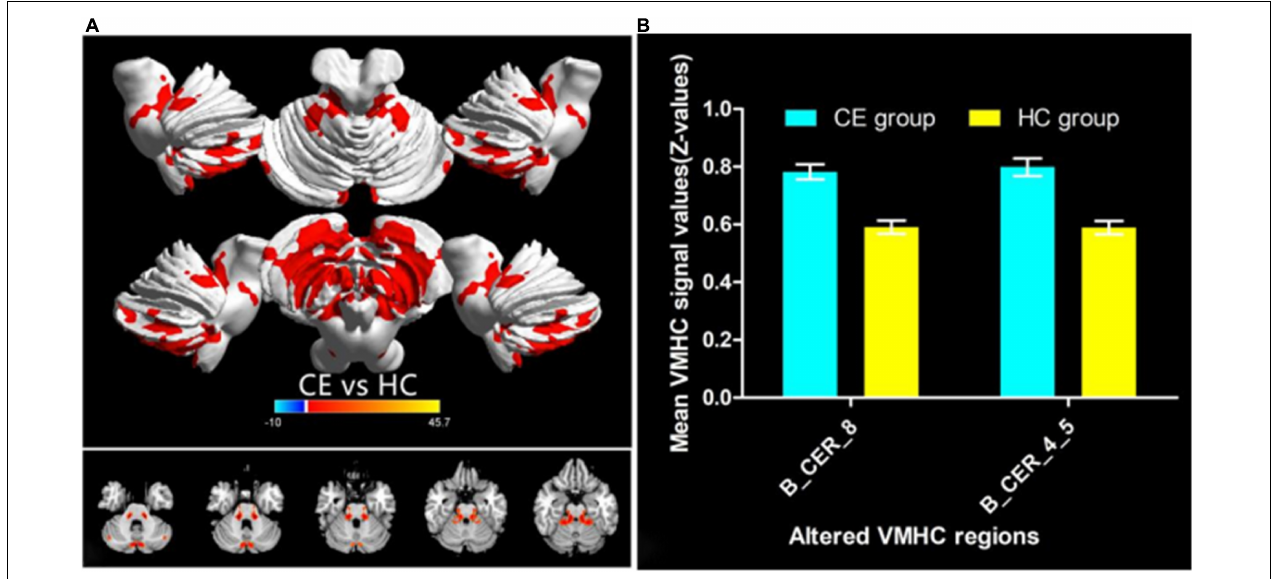
FIGURE 2 | Significant VMHC differences in the CE and HC group (A) ; the mean of altered VMHC values between patients with CE and HCs (B) . Abbreviations: CE, comitant exotropia; HC, health control; VMHC, voxel-mirrored homotopic connectivity; and CER, cerebellum.